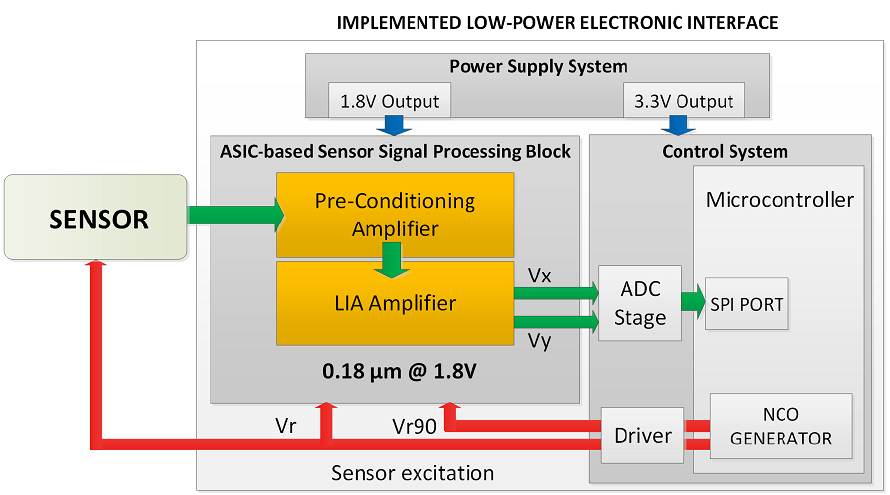
Figure 1. Electronic interface for portable sensing